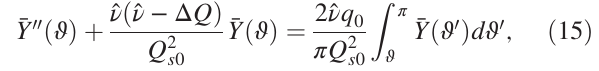
TABLE I. The lower-order tems of the matrix R